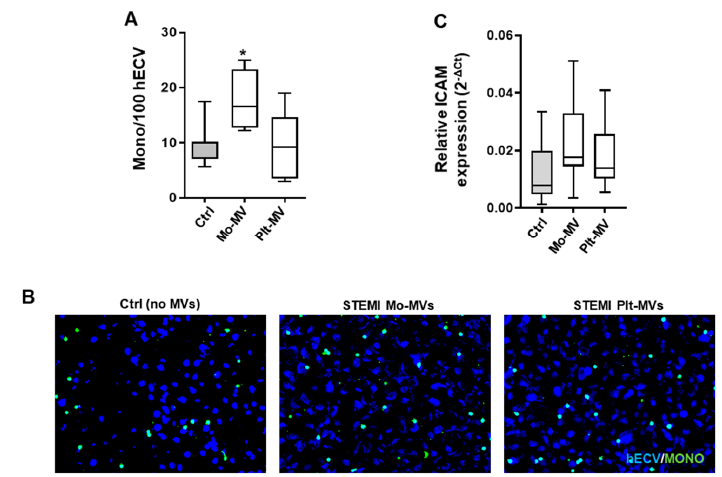
Figure 6. MV effects on monocytes adhesion to endothelial cells treated with MVs released by cells of STEMI patients. hECV were stimulated for 6 h with MVs released from monocytes ( n = 5) and platelets ( n = 7), isolated from STEMI patients. ( A ) hECV cells were challenged 1 h with 200 MV/µL and then incubated 1 h 30 min with monocytes (from healthy donors) stained with calcein. Number of monocytes on hECV was quantified by ImageJ fluorescence. Data are represented in box and whisker plot (min to max) and are expressed as number of adherent monocytes on 100 hECV cells. ( B ) Representative images of adhesion assay: hECV nuclei stained with DAPI, monocytes stained by calcein, magnification 200 × . ( C ) ICAM gene expression. Data are represented in box and whisker plot (min to max) of 2- ∆ Ct. One way ANOVA with Dunnett’s test for multiple comparison was used to analyze data. * p < 0.05 vs. Ctrl (untreated cells).